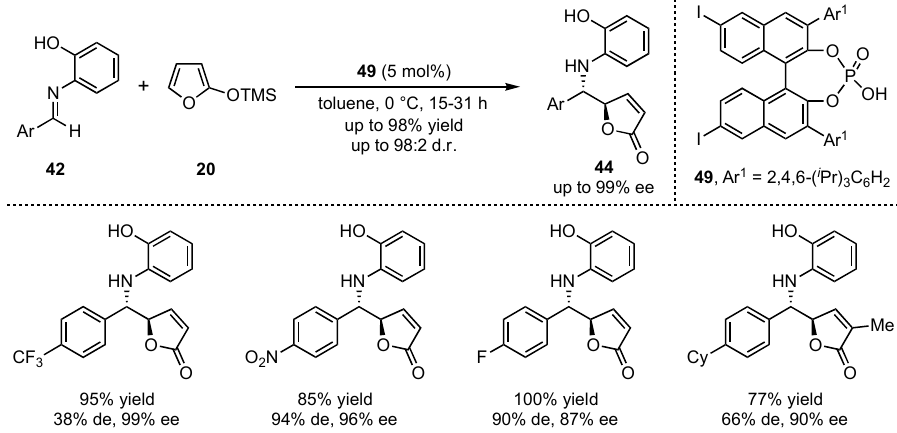
Scheme 13. First organocatalytic approach of the asymmetric VMMnR in the formation of γ -butenolides by Akiyama et al. [45].